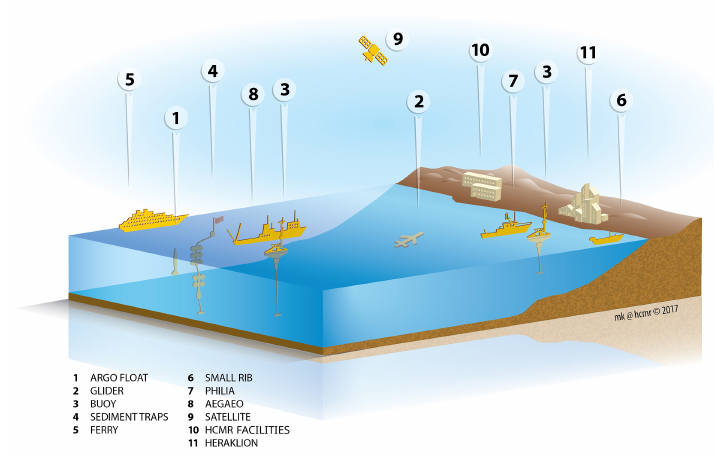
Figure 2. Platforms of the Cretan Sea biogeochemical-ecosystem observatory.